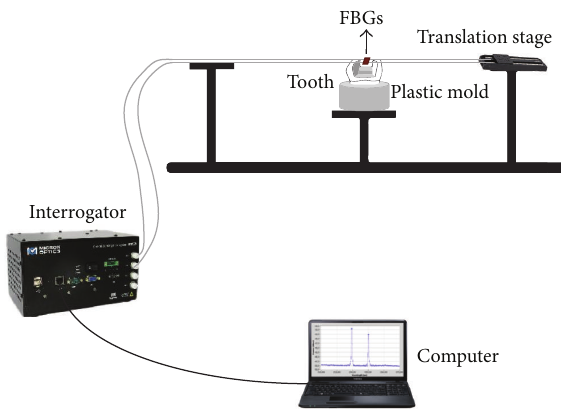
Figure 2: Schematic overview of the experimental setup used to measure the setting cuspal deformation and the temperature variation.